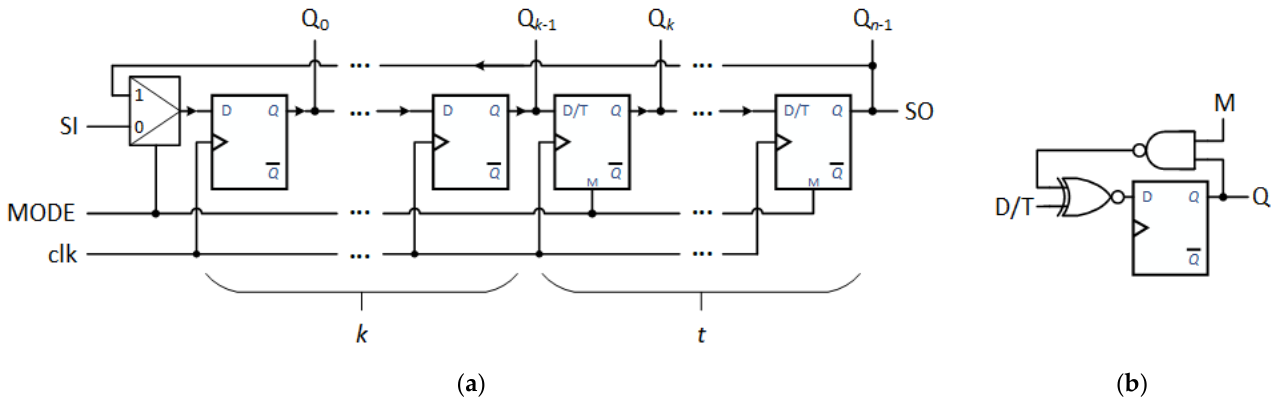
Figure 13. n -bit DT-LFSR: ( a ) Diagram of the internal structure of the synthesizable register model; ( b ) Internal structure of the configurable D/T flip-flop.